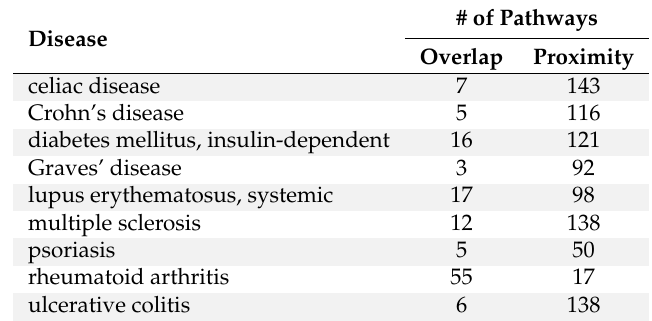
Table 1. Number of pathways enriched across nine autoimmune disorders based on the overlap between the pathway and disease genes (one-sided p ≤ 0.05, assessed by a Fisher’s exact test) and the proximity of the pathway genes to the disease genes in the interactome ( z ≤ − 2, see Methods for